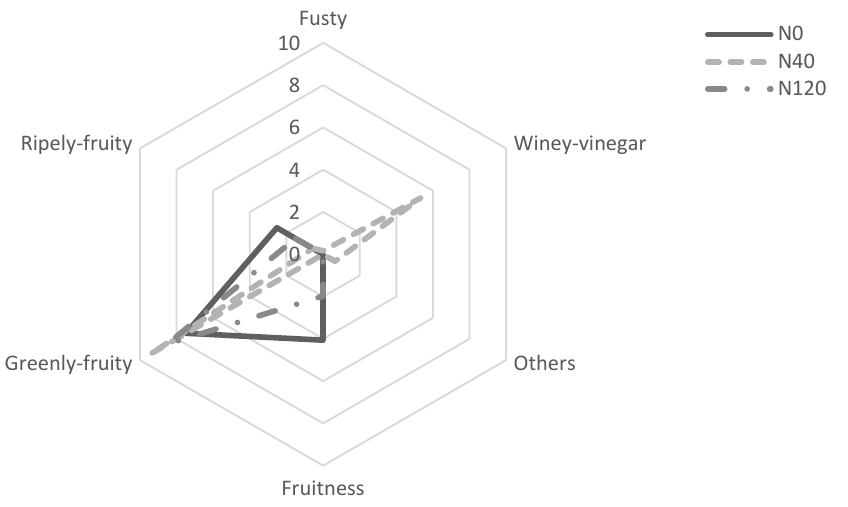
Figure 4. Sensory profiles of virgin olive oils obtained from olives harvested in 2018 and olive trees supplied with 0 (N0), 40 (N40) and 120 (N120) kg ha −1 of N.